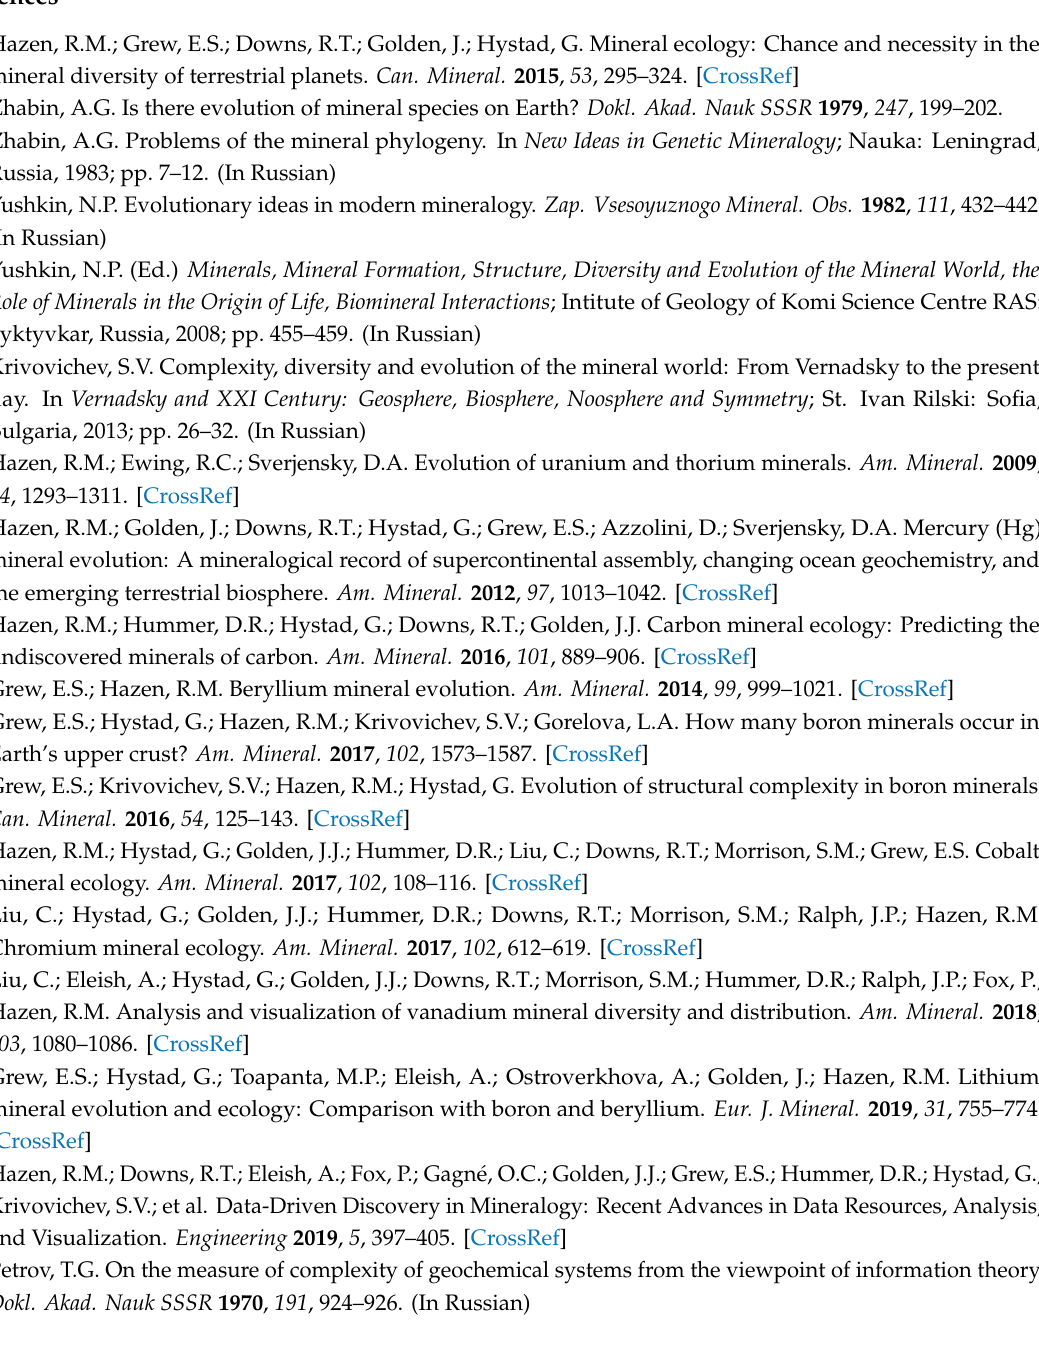
Table S1: Tellurium minerals: Number of species-defining’s elements ( N ) chemical formula, and number of localities (NL); Table S2: Classification of mineral systems of tellurium minerals according to number of species-defining elements ( N ) an chemical